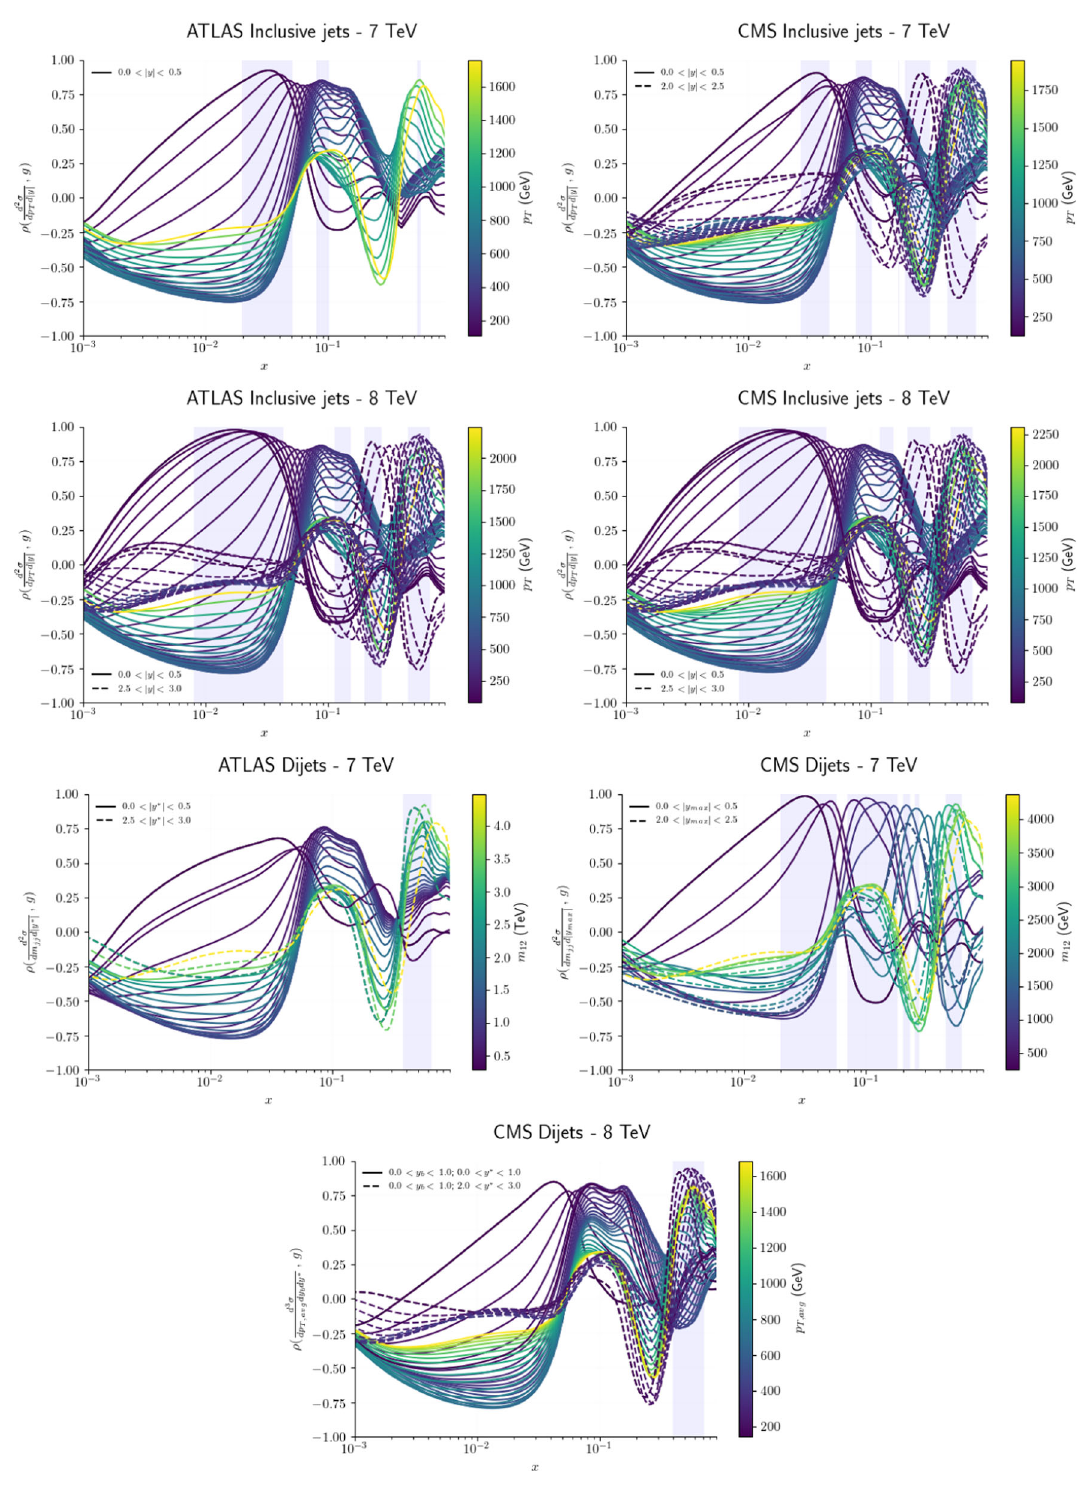
Fig. 5 Correlation coefficients between the data of Table 1 and the gluon PDF g ( x ) . Each curve corresponds to a different datapoint, with the value of p T corresponding to the color code on the right of the plot, and only curves for the points in the largest and smallest rapidity bins